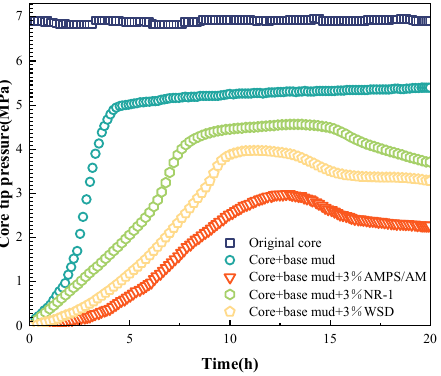
Figure 2. Pressure variation curve at the end of the core after the action of the fluid to be tested.